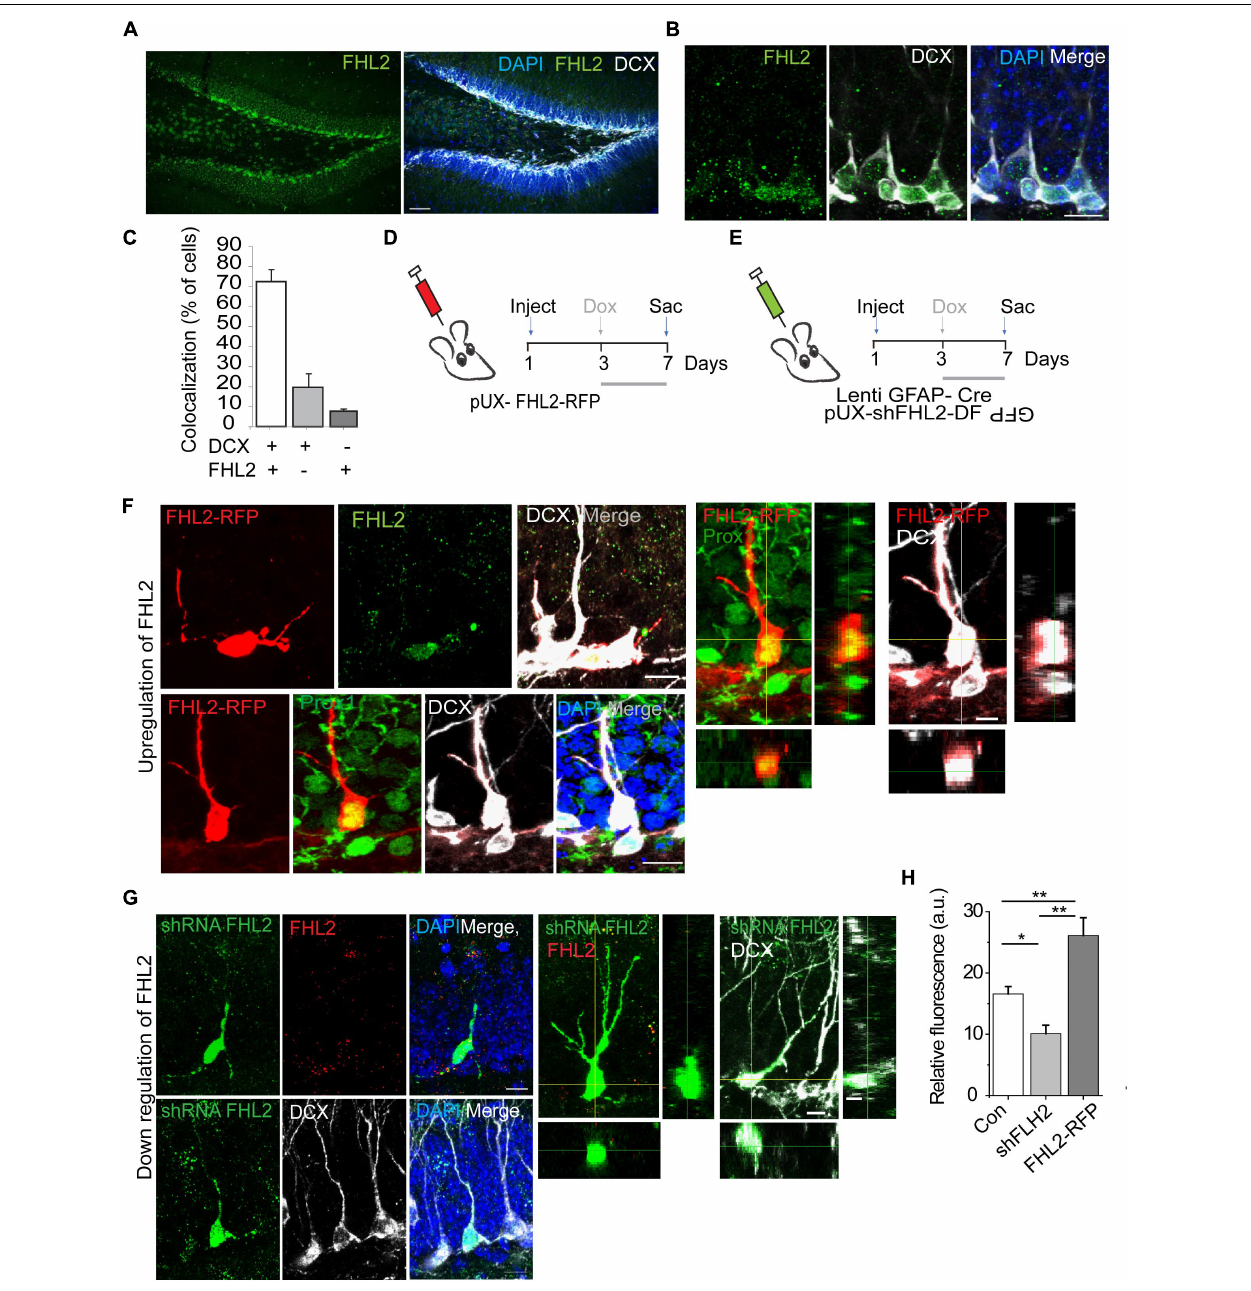
FIGURE 3 | Endogenous expression and successful manipulation of FHL2 in adult-born DGCs. (A) Representative coronal section of the DG immunolabeled with FHL2 and DCX. Scale bar, 100 µ m. (B) Representative image of the dentate gyrus labeled with FHL2 colocalized with DCX. Scale bar, 10 µ m. (C) Quantification of colocalization between DCX and FHL2 in the dentate gyrus. (D) Experimental timeline of inducible overexpression of FHL2 in adult-born DGCs with doxycycline induction (dox) at 3 dpi and sacrifice (sac) at 7 dpi. (E) Experimental timeline of inducible downregulation of FHL2 in adult-born DGCs with doxycycline induction (dox) at 3 dpi and sacrifice (sac) at 7 dpi. (F) Representative image of a newborn neuron at 7 dpi overexpressing FHL2 with FHL2 signal shown (top) and Prox 1 colocalization shown (bottom). Orthogonal views of the expression of Prox1 and DCX in RFP positive cells shown in the right panels. (G) Representative images of newborn neurons (DCX +) at 7 dpi with viral-mediated FHL2 knock-down. Orthogonal analysis of the expression of FHL2 and DCX colocalization shown in the right panels. (H) Quantification of relative fluorescence of FHL2 signal in control (con) newborn DGCs, shFHL2 cells, and FHL2-RFP cells ( n = 103 cells) at 7 dpi. One-way ANOVA F (2,67) = 15.64, P < 0.0001. Followed by post hoc Tukey HSD tests, con vs. shFHL2, P = 0.037; con vs. FHL2-RFP, P < 0.01; shFHL2 vs. FHL2-RFP, P < 0.01, * P < 0.05, and ** P < 0.01. Error bars, SEM. N = 3–4 mice per condition. Data are presented as mean ± SEM, Con, control.